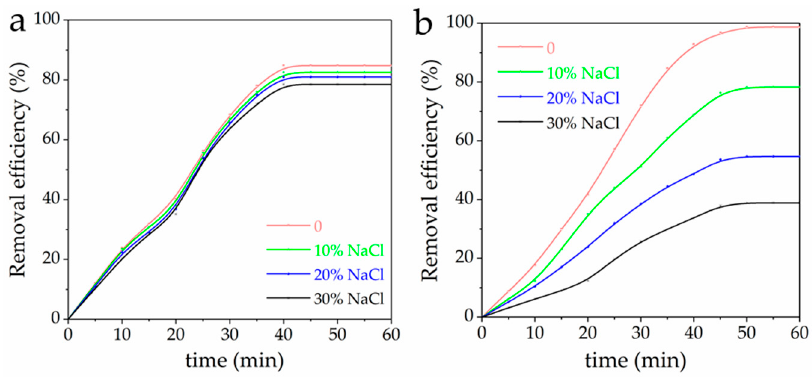
Figure 10. Simultaneously removing ( a ) Cr(VI) and ( b ) aniline at various NaCl contents. ( c 0 (Cr(VI)) = 40.0 mg·L − 1 , c 0 (aniline) = 100.0 mg·L − 1 , c (MFH) = 0.10 g·L − 1 , pH = 3.0, T = 25 °C).